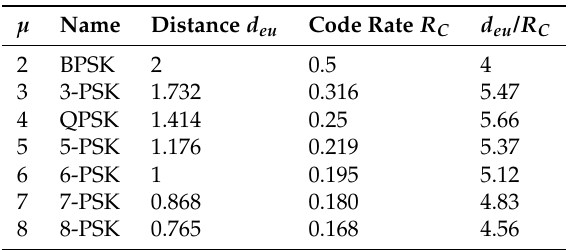
Table 1. Modulation and coding schemes for the transmission of 128 information bits in 256 µ -phase shift keying (PSK)